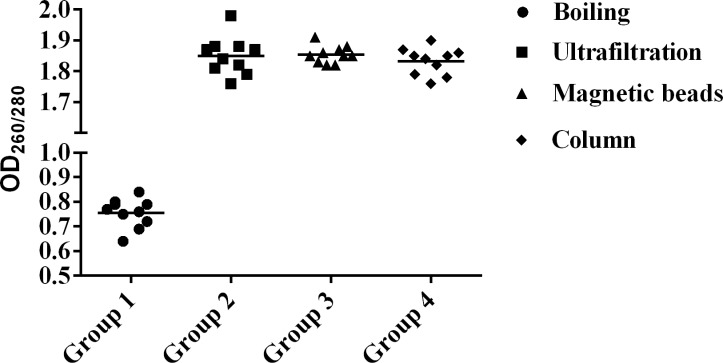
OD260/280 ratioof DNA samples prepared using various methods.